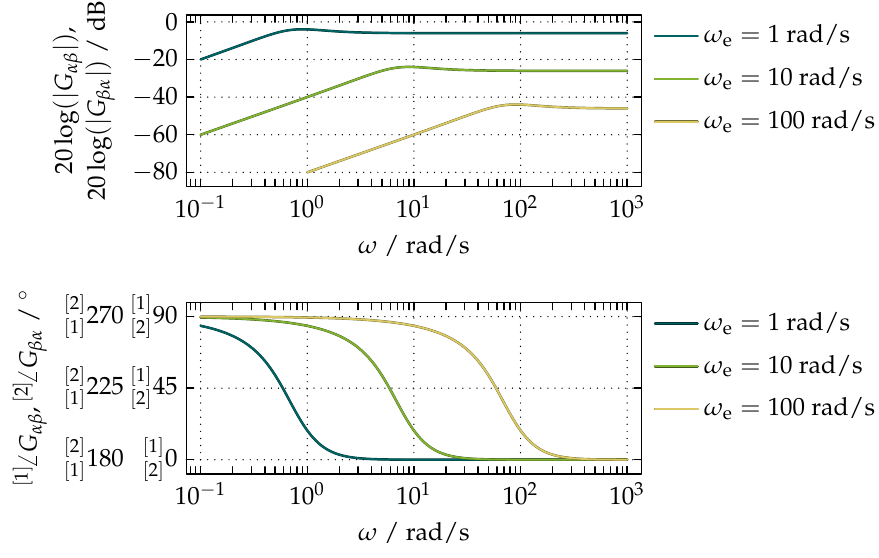
Figure 6. Bode plots of G αβ and G βα , with a common magnitude plot, showing the dependence of the frequency response of the proposed compensation on ω e , where the superscripts of the phase plot index the transfer function for the positive direction of rotation, while the subscripts index the negative